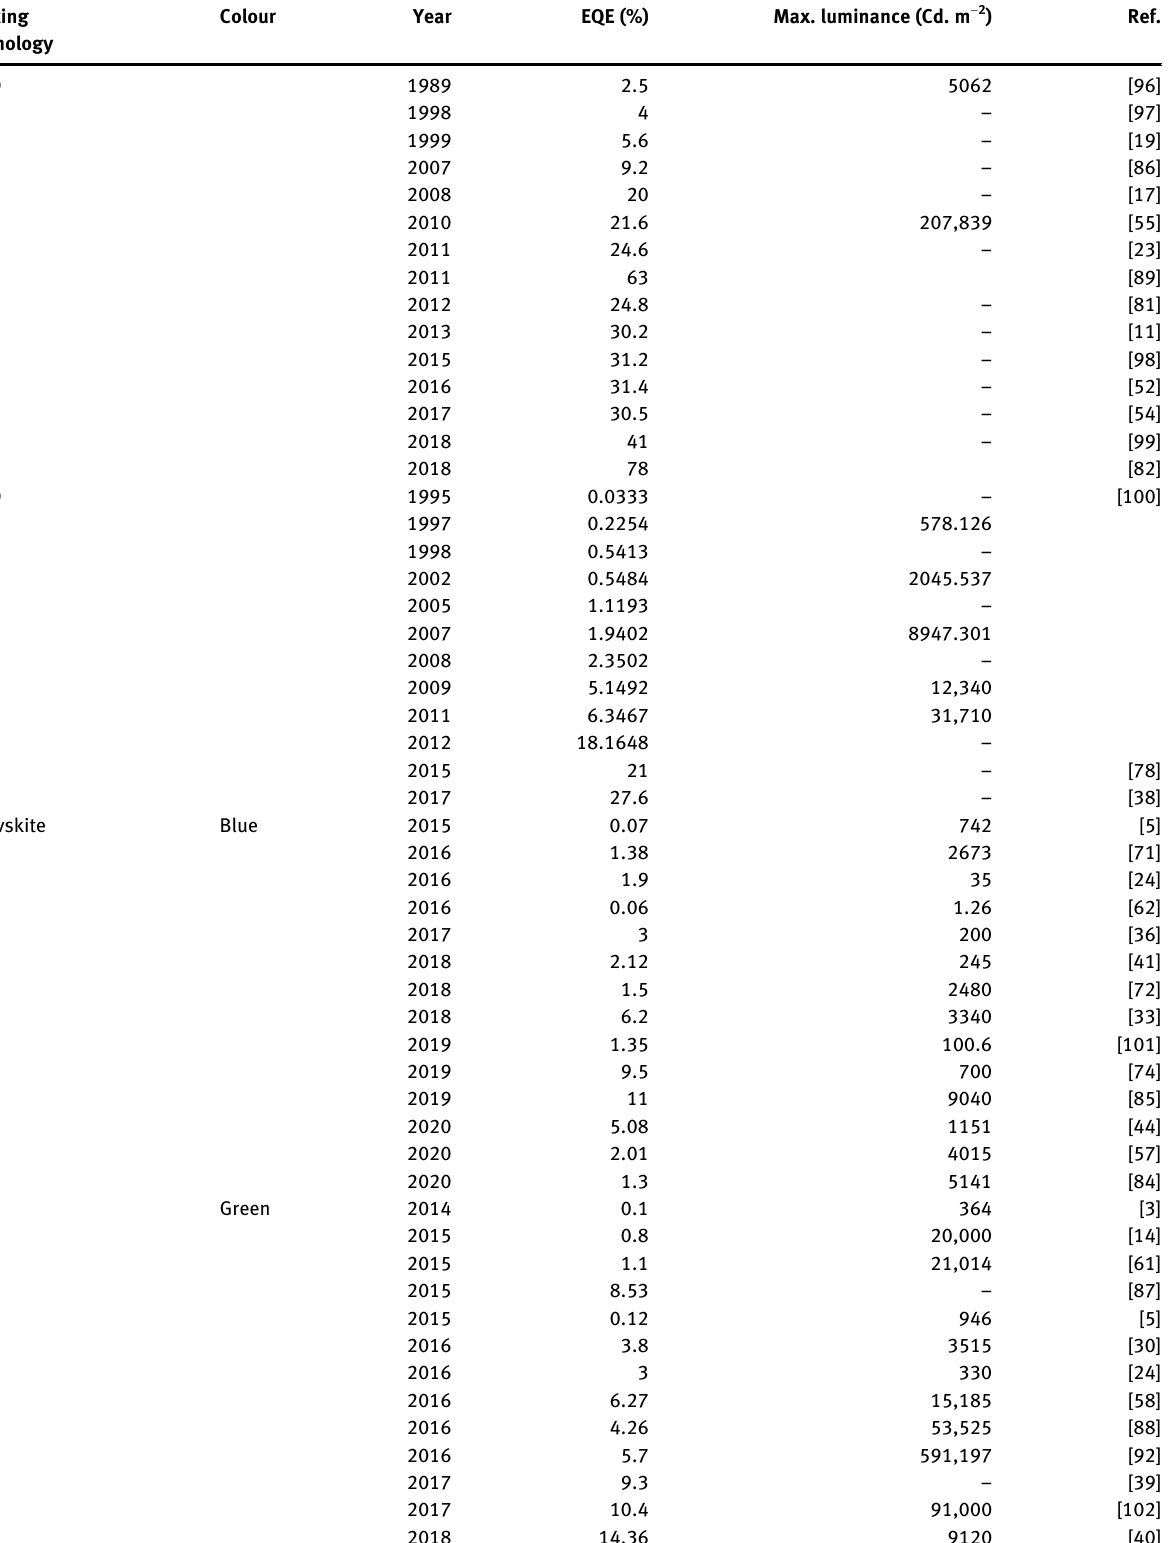
Table  : Summary of recent advances in red, blue, green and near-IR LEDs based on organic emitters, quantum dots and perovskites. Lighting